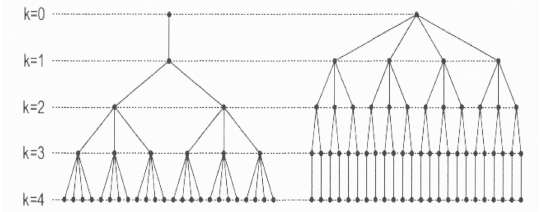
Figure 1 . Super trees: (a) growing tree T + with p 0 branches at the root point and a = 1 , (b) descending tree T − with p = 4 branches and a = − 1 0